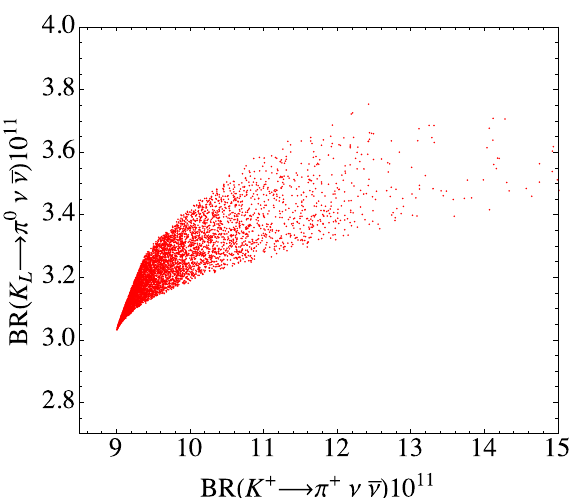
(cid:25) + (cid:23) (cid:22) (cid:23) ) and (b) BR ( K L !